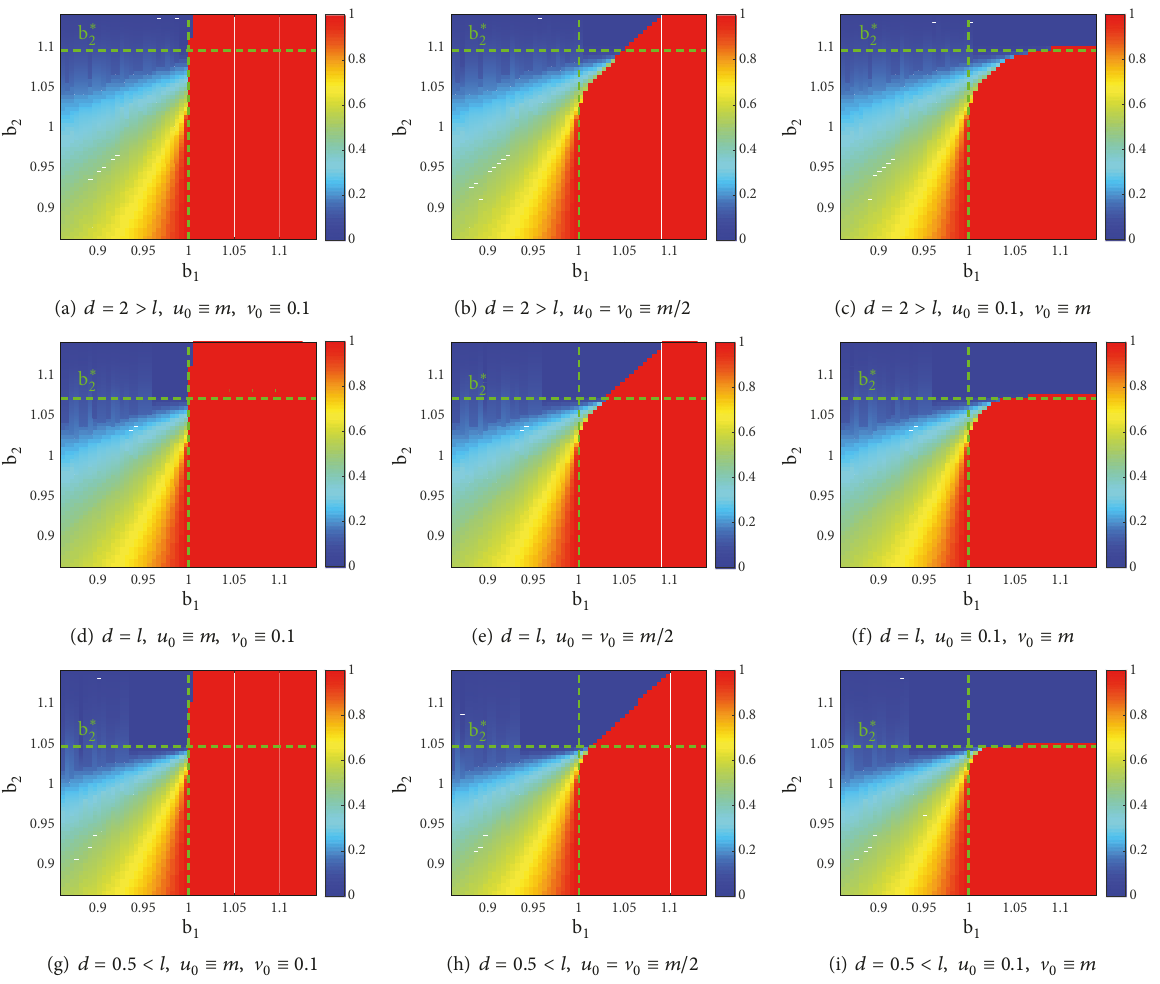
Figure 1: SDD 1 versus RD: in the situation of Theorem 2, the mass ratio ∫𝑢(𝑡)𝑑𝑥/ ∫(𝑢 + V )(𝑡)𝑑𝑥 of numerical solutions is plotted at 𝑡 = 1000 with the parameters in (14). In the red and blue region SDD 1 and RD prevail, respectively. In any cases the SDD 1 survives near 𝑏 1 = 𝑏 2 = 1 even if RD is stronger than SDD 1 ( 𝑏 2 > 𝑏 1